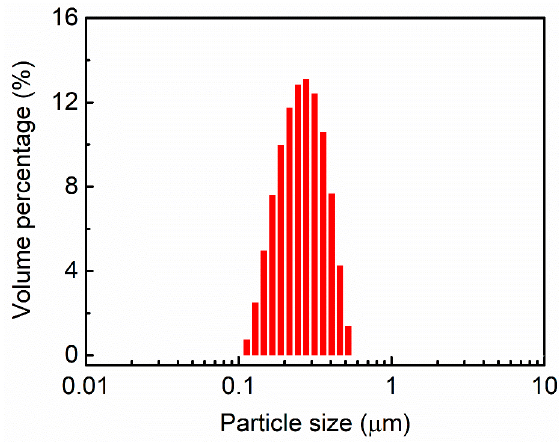
Figure 4. Particle size distribution of TiO 2 dispersed in water.